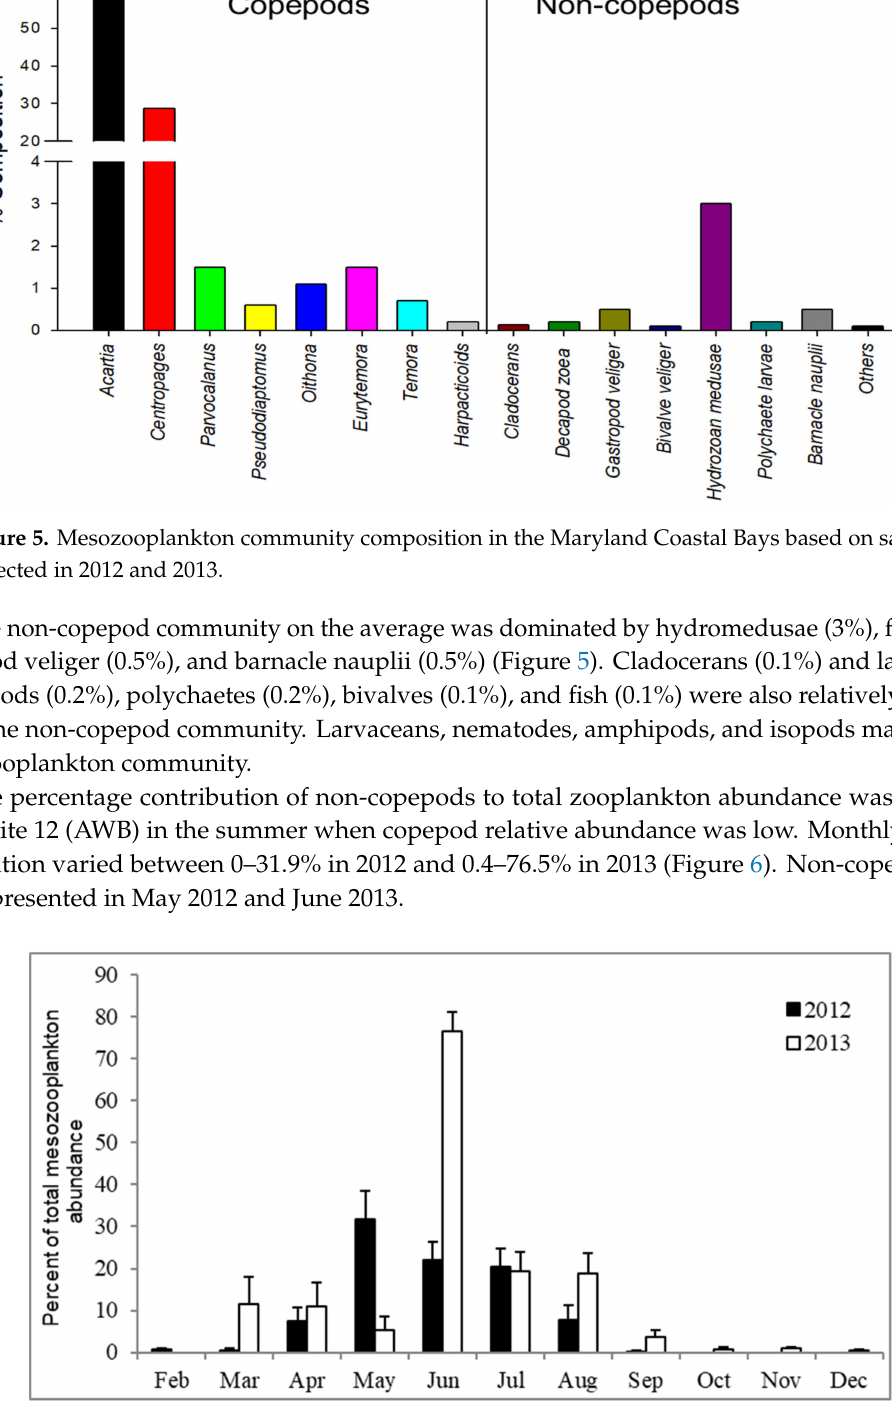
Figure 6. Percentage contribution by number of non-copepod taxa to total mesozooplankton abundance ( + SE) in the Maryland Coastal